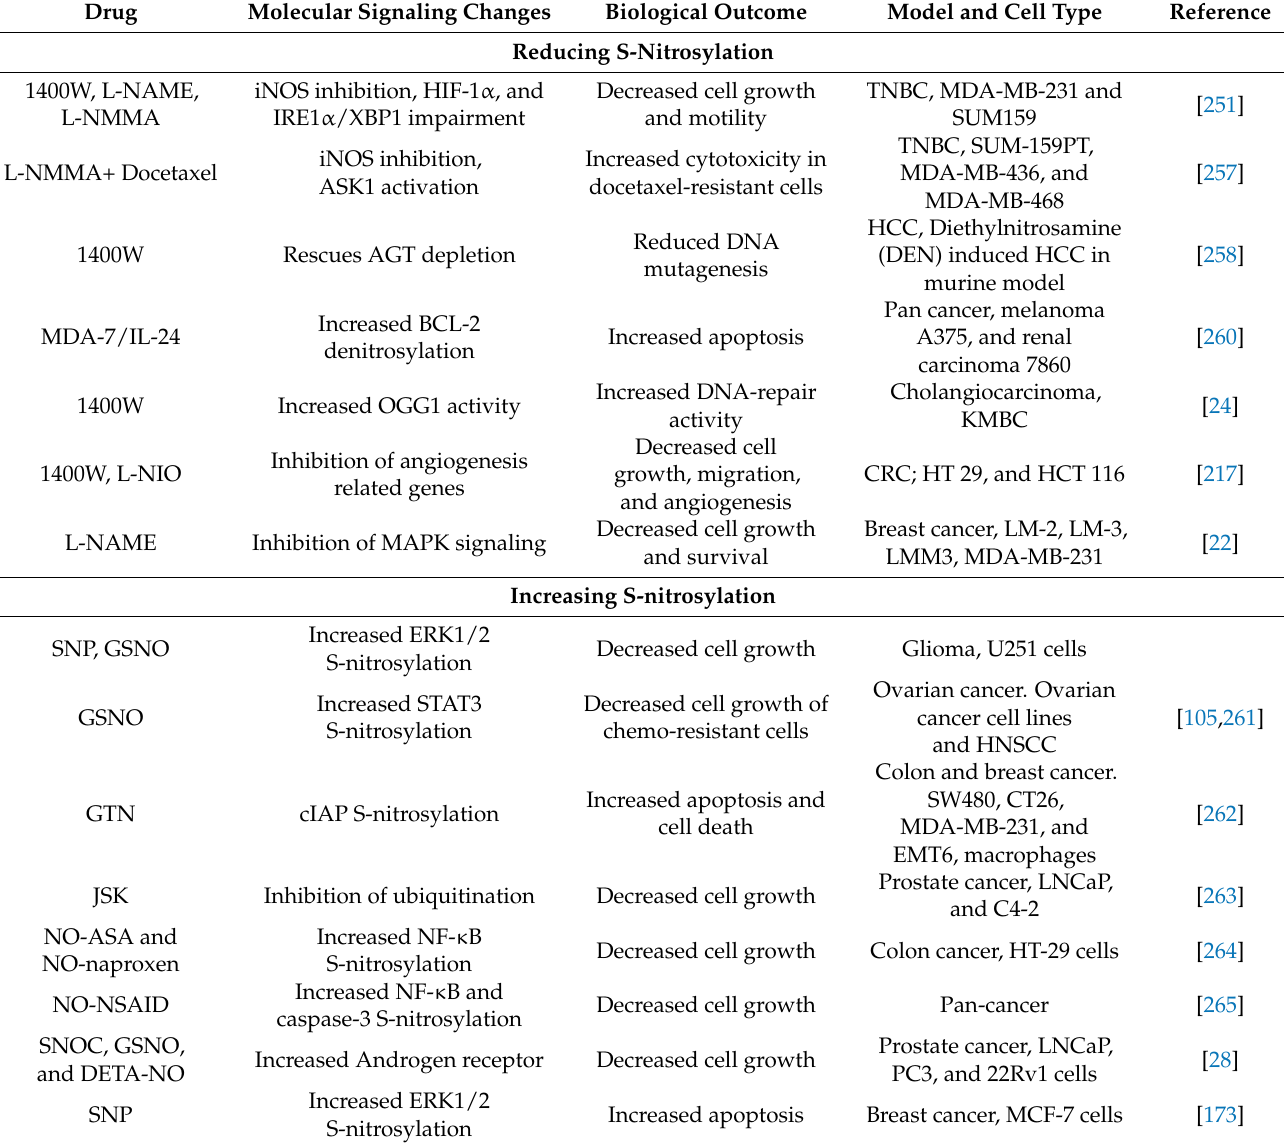
Table 3. S-Nitrosylation in anti-cancer